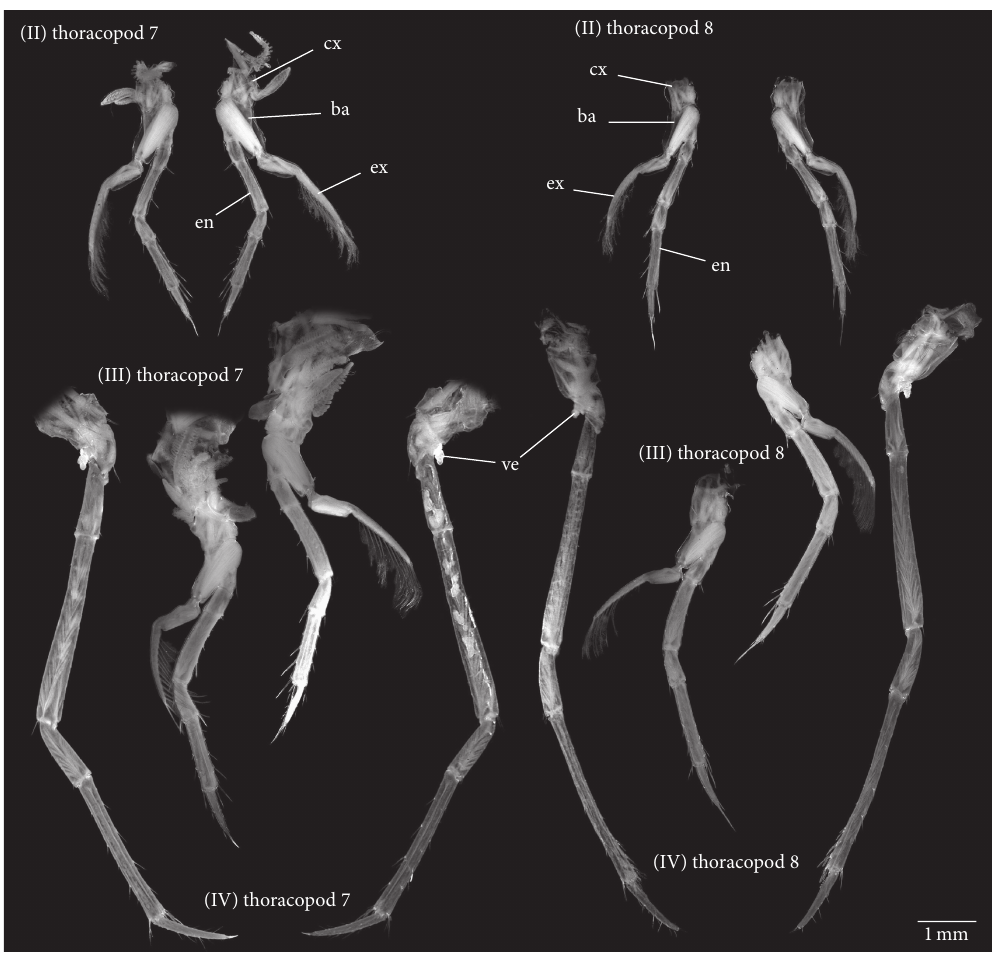
Figure 9: Thoracopods 7 and 8 of larval stages (II) to (IV) of Homarus gammarus . Right appendage in anterior (left) and posterior (right) view. Labeling only given in one instance due to the similarity of the structures throughout all stages. ba = basipod; cx = coxa; en = endopod; ex = exopod; ve = vestigial